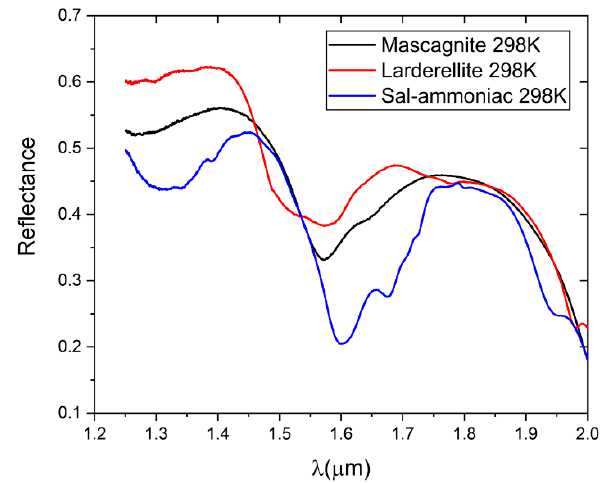
Figure 13. Comparison of part of the reflectance spectra of mascagnite, larderellite and sal-ammoniac. Focus between 1.2 and 2.0 μ m indicates the 2v 3 (NH 4+ ) bands.